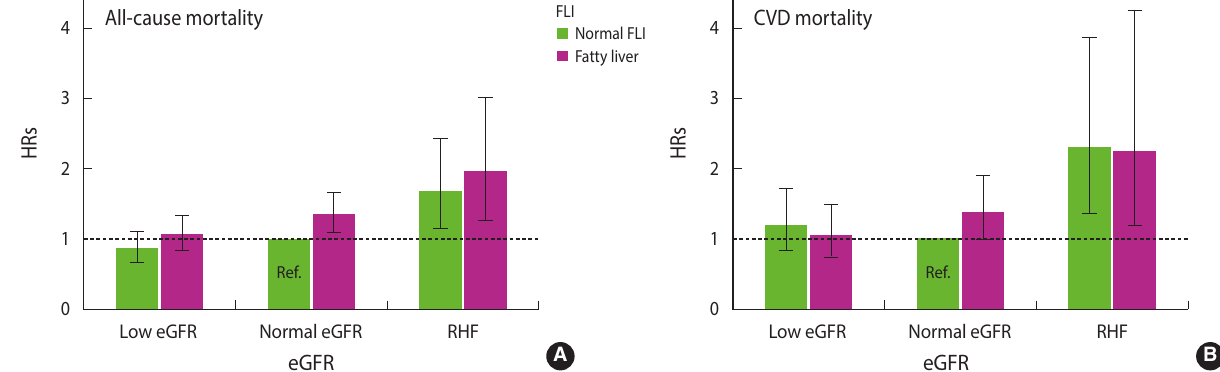
Figure 1. Fully adjusted hazard ratios (HRs) with 95% confidence intervals for (A) all-cause and (B) cardiovascular disease (CVD) mortality with respect to kidney (eGFR) and liver (FLI) functions. eGFR, estimated glomerular filtration rate; RHF, renal hyperfiltration; FLI, fatty liver index; Ref, Table 3. HRs for all-cause and cardiovascular disease mortality in the study population (n=1,552) All-cause mortality Cardiovascular disease mortality Characteristics